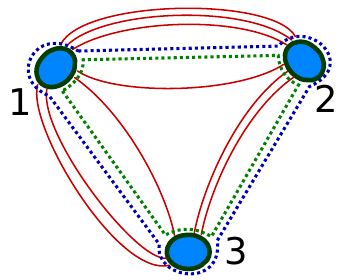
Figure 2 . A planar three-point function can be split into an inner and an outer hexagon (green and blue dotted lines, respectively). This splitting partitions the Wick contractions (crimson solid lines) among the two hexagons. In the BKV proposal, we should sum over all these partitions with appropriate